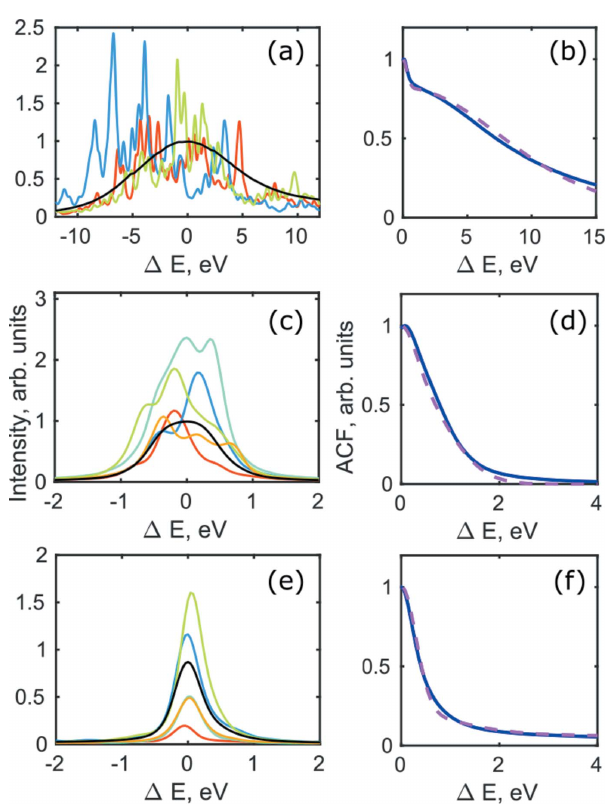
Figure 3 ( a , c , e ) Spectral distribution of a few random pulses and an average spectrum for all pulses (black lines). ( b , d , f ) Average autocorrelation function of all spectral lines (full lines), and its fit (dashed lines) by two Gaussian functions. ( a , b ) SASE radiation, ( c , d ) monochromatic radiation, ( e , f ) self-seeding regime of operation. All results presented in this figure correspond to the 180 pC bunch